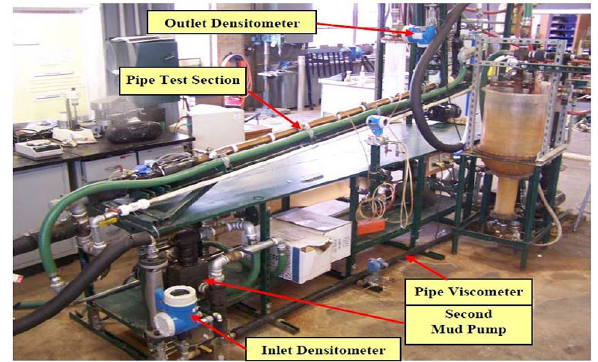
Fig. 1 Used loop flow equipment [8]